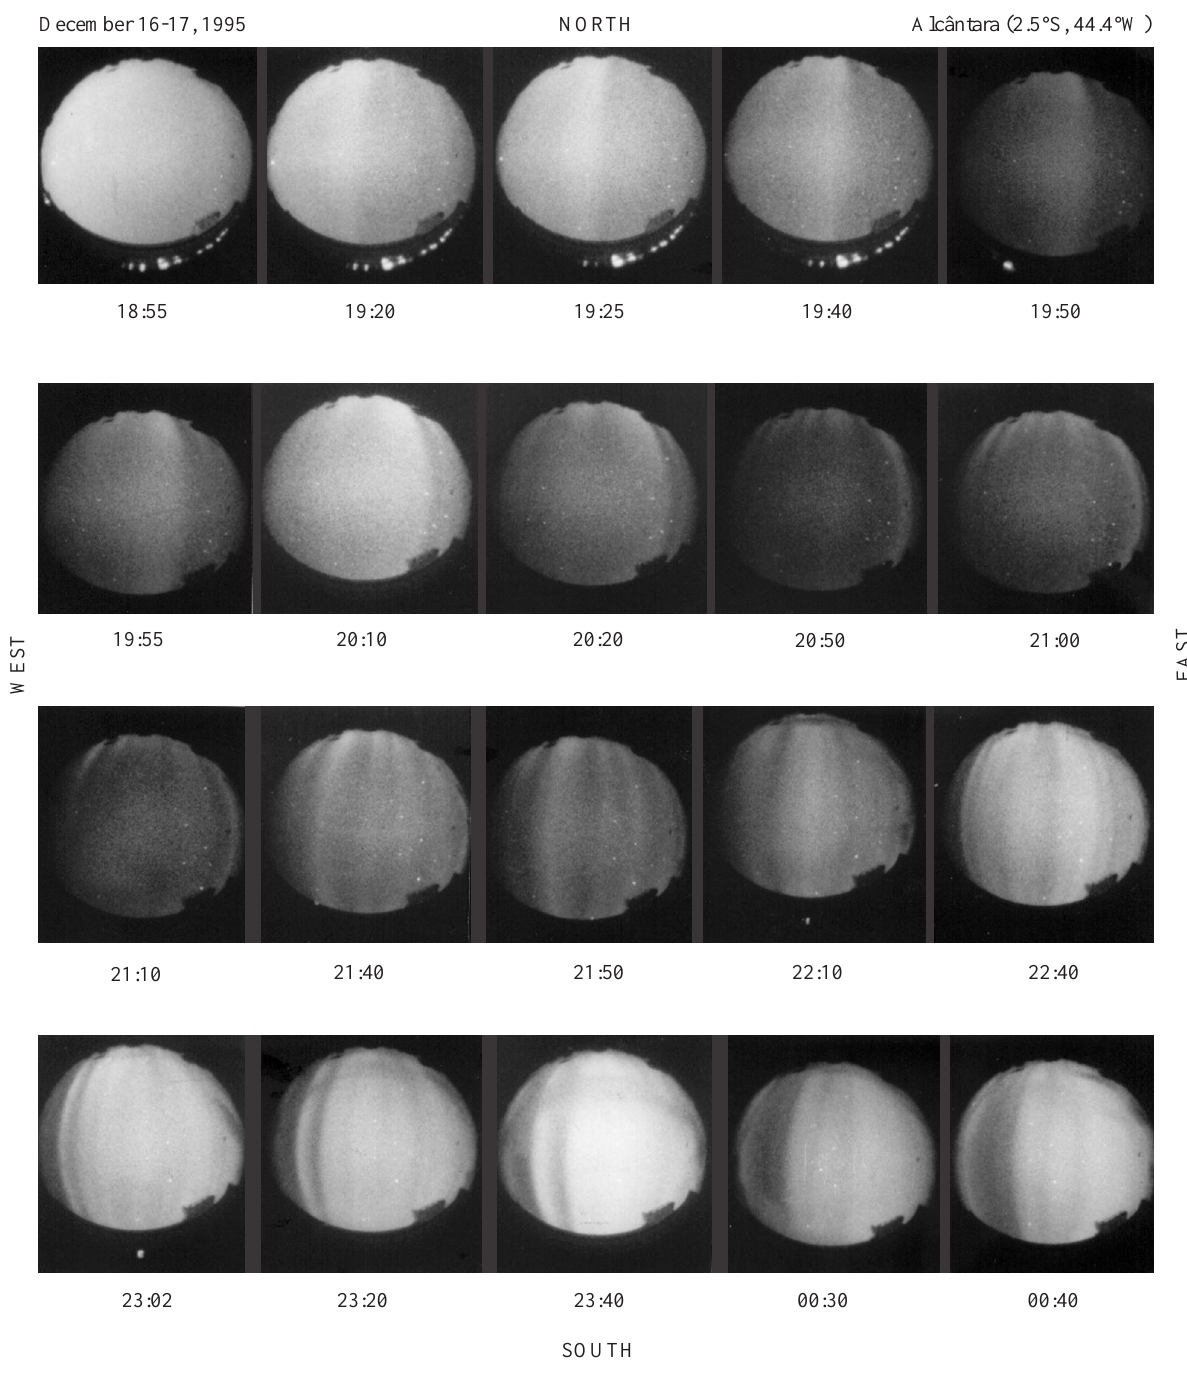
Fig. 4. Same as Fig. 3, but for December